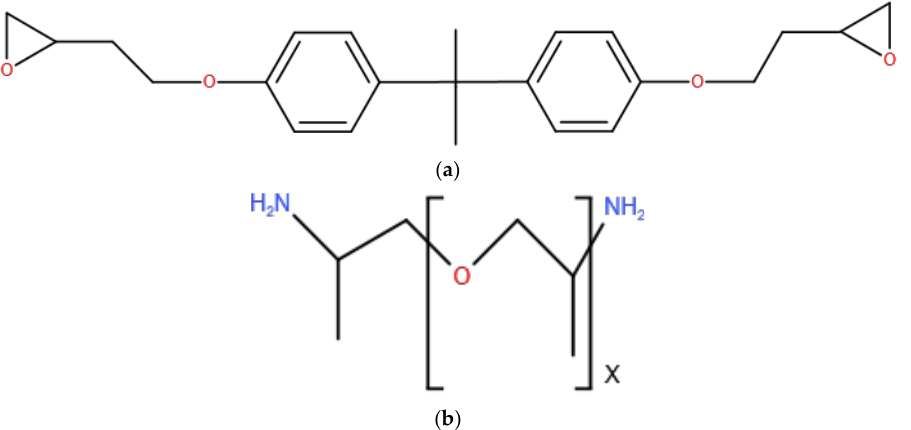
Figure 1. Molecular structure diagram of ( a ) DGEBA and ( b ) JEFFAMINE ® -D230 (x = 2.6) molecule.